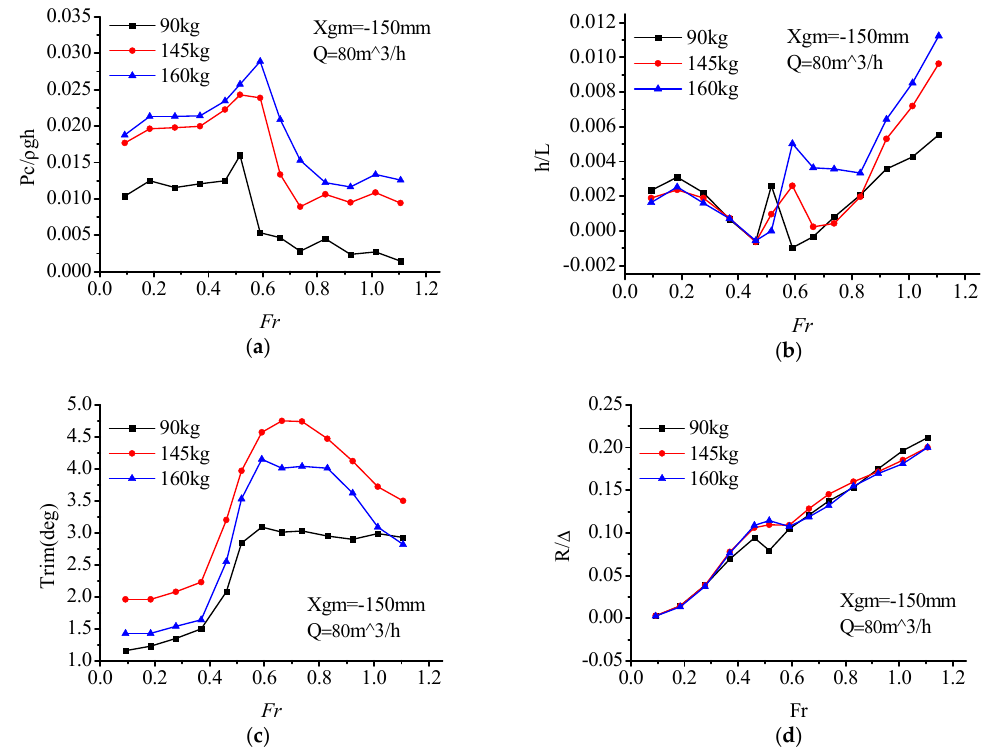
Figure A1. Comparisons of numerical and experimental results with consistent airflow Q = 80 m 3 / h. ( a ) Curves of air cushion pressure; ( b ) Curves of air cushion heave; ( c ) Curves of trim angle; ( d ) Curves of total